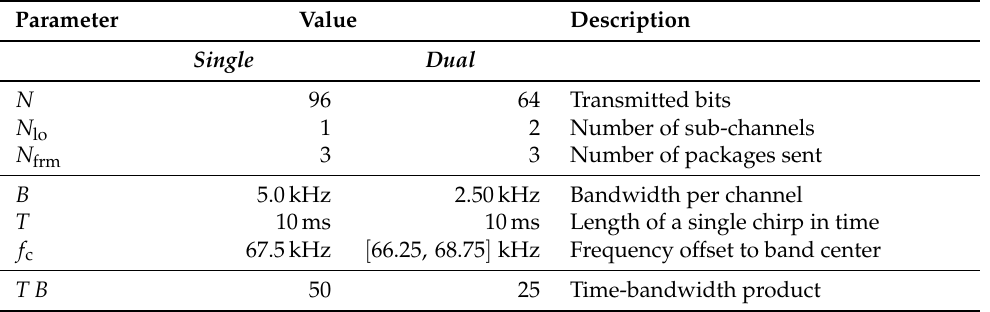
Table 2. Experiment Waveform Parameters.